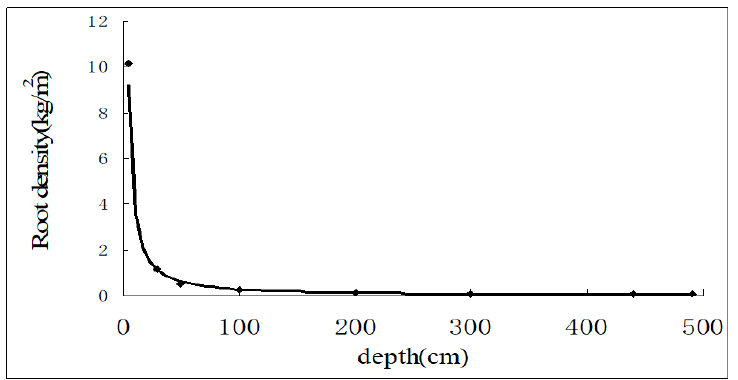
Figure 2. Root distribution of 16-year-old Caragana korshinskii shrubs in the semi-arid hilly region of the Loess Plateau.